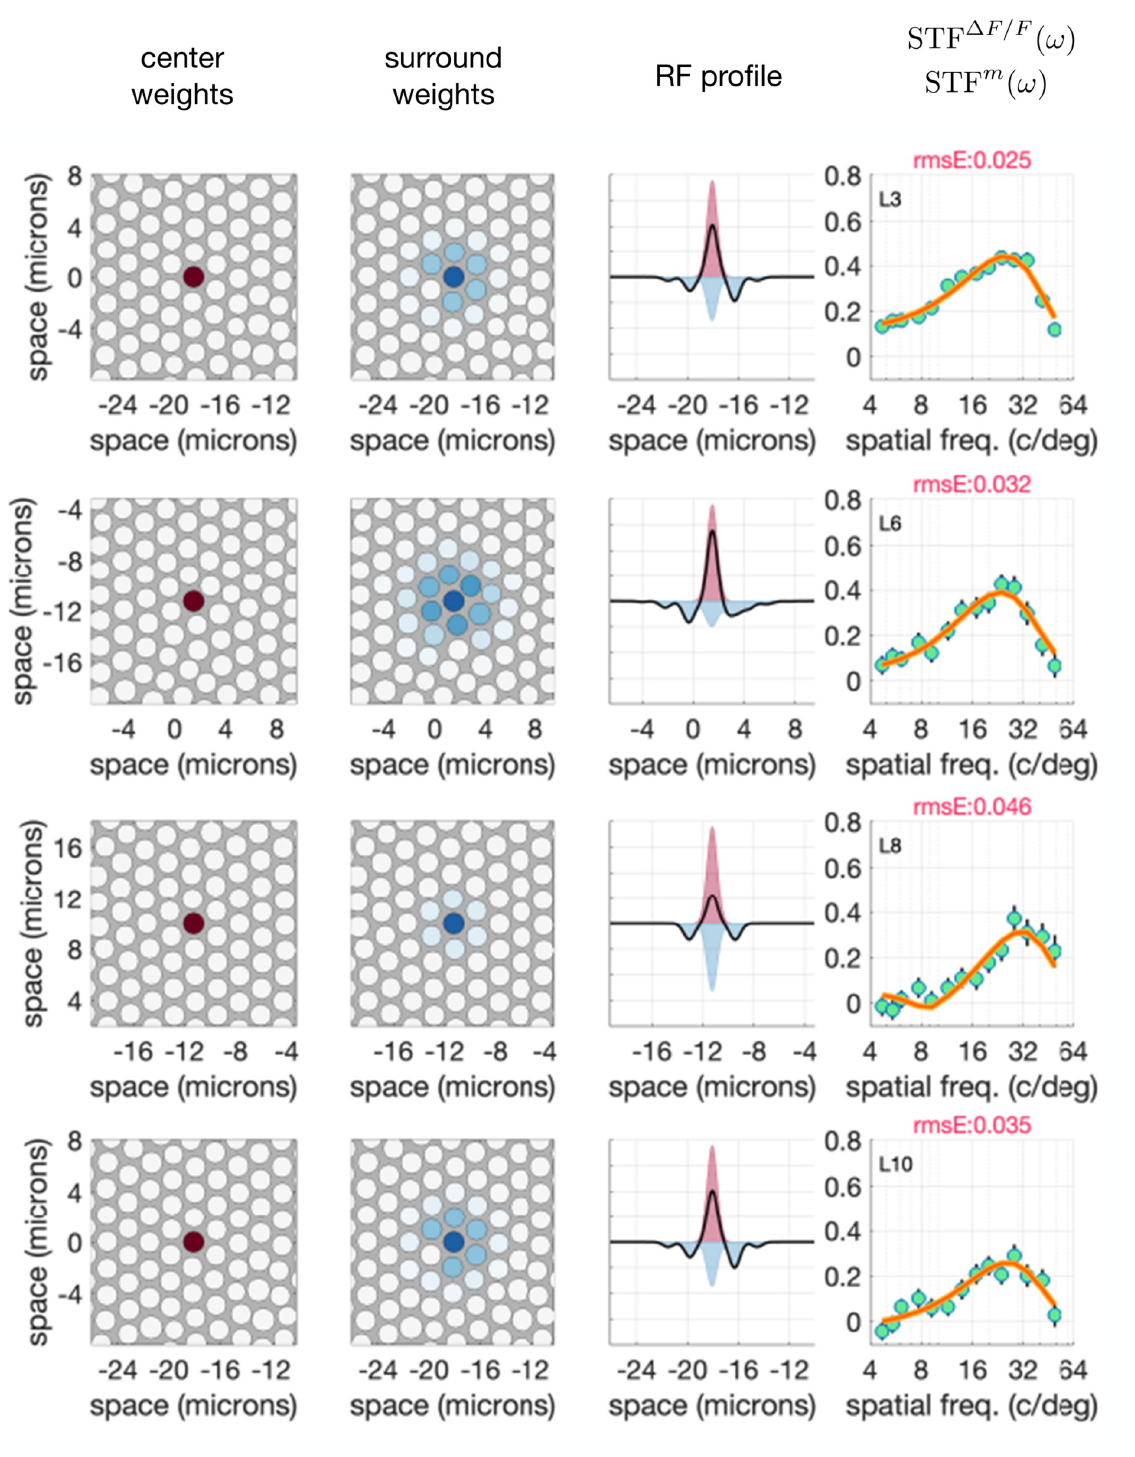
Fig 8. ISETBio model receptive field estimates for four additional RGCs. Each row shows the model fits to a different cell’s STF using the single cone center/0.067D residual defocus model.